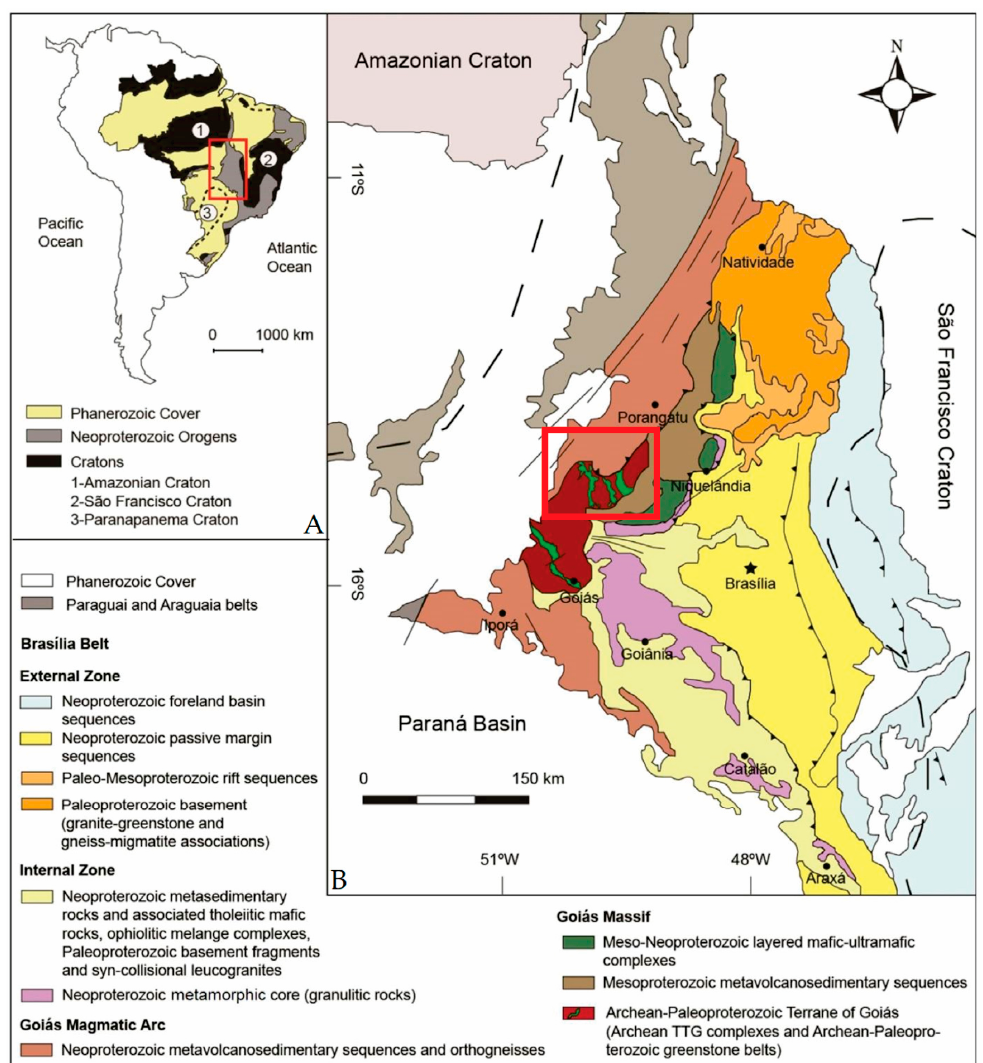
Figure 1. ( A ) Major geological units of Brazil represented by undivided Phanerozoic cover (basins), Neoproterozoic Orogens (fold belts) and Cratons. Location of the Tocantins Province in Central Brazil is highlighted by the red rectangle. ( B ) Highlighted area in ( A ) showing the Brasília Fold Belt units and the allochthonous Archean-Paleoproterozoic Terrane of Goiás in its western edge (modified after [26,27]). Red rectangle features the northern section of the Terrane, in which light green stripes represent the ~N-S trending greenstone belts of Crixás, Guarinos and Pilar de Goiás (from W-E), while maroon color stands for adjacent Archean TTG complexes (tonalite-trondhjemite-granodiorite orthogneisses). PGGB consists of a greenschist [28] to amphibolite facies [29] metavolcanosedimentary